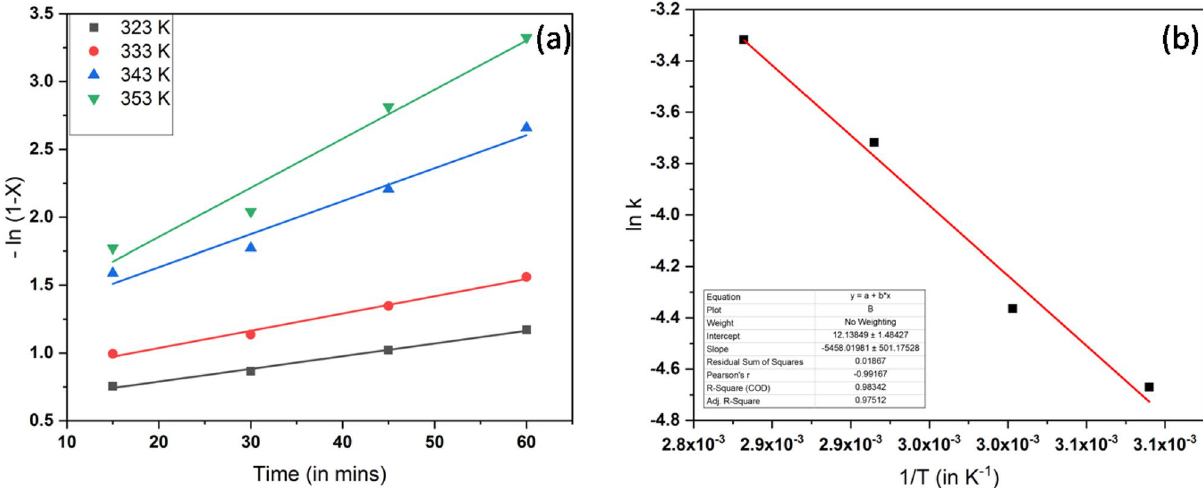
Figure 10. Kinetic study of the reaction ( a ) reaction rate ( b ) Arrhenius